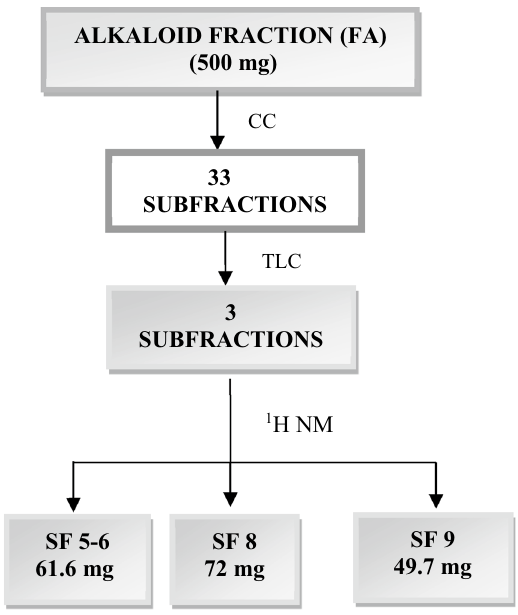
Figure 5. Flowchart for obtaining SF 5–6, SF8 and SF9